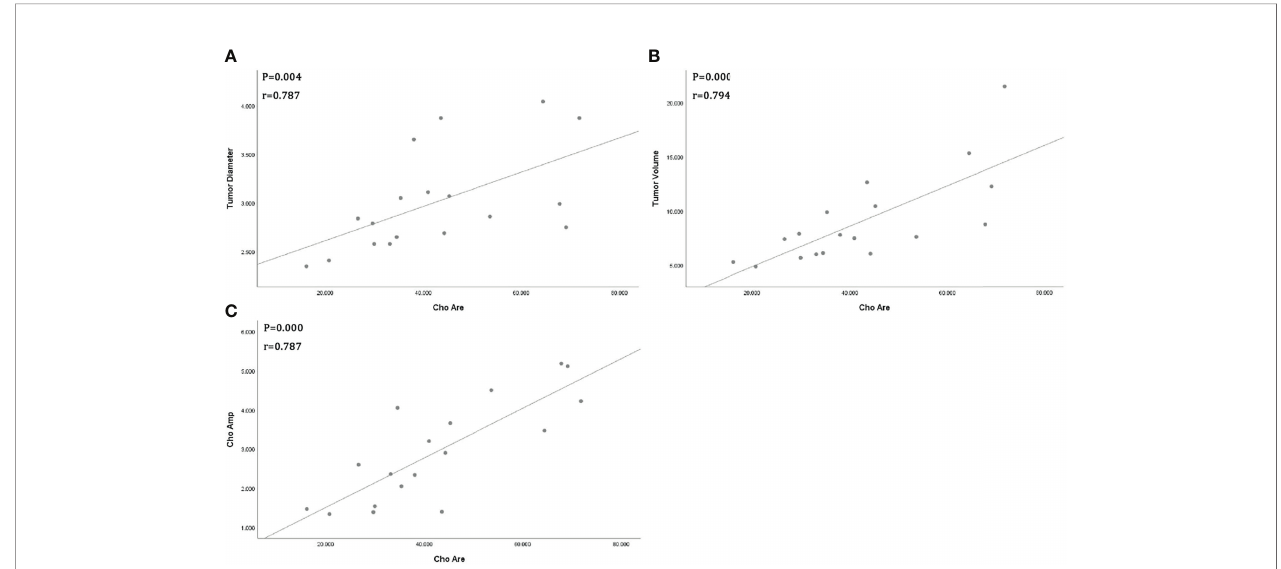
FIGURE 2 | Scatter plot represent positive correlations between Choline (Cho) peak area and tumor diameter (A) , tumor volume (B) , and Cho peak amplitude (C) ,